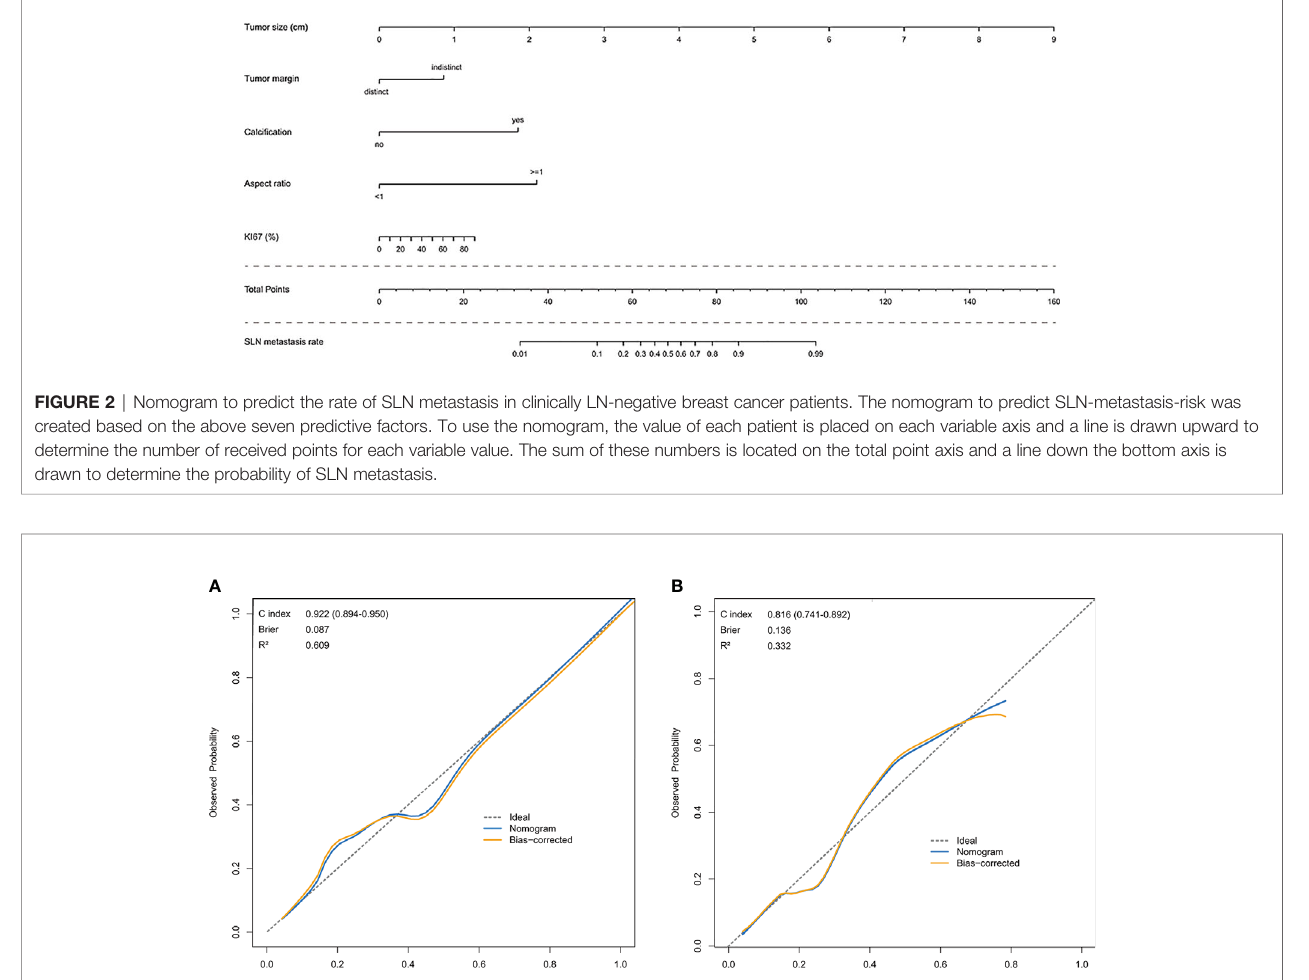
FIGURE 3 | Calibration curve comparing predicted and actual SLN-metastasis-risk probabilities. (A) Calibration curve of the nomogram in the training cohort. (B) Calibration curve of the nomogram in the validation cohort. The calibration curve describes the calibration of the model according to the consistency between the predicted risk of SLN metastasis and the observed results of SLN metastasis. The x-axis represents the predicted probability of SLN metastasis. T The y-axis represents the actual SLN metastasis probability. he gray dotted line represents the perfect prediction of the ideal model. The solid blue line represents the prediction of the nomogram, and the solid orange line represents the bootstrap-corrected estimates. A well calibrated curve of a nomogram would be near the ideal